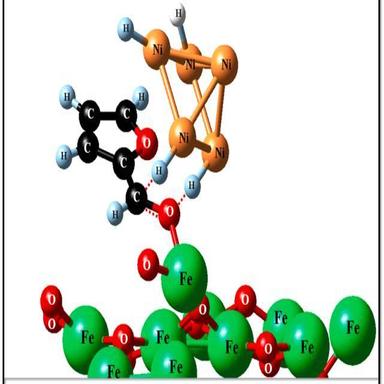
Furfural molecule. Fig. 16. Schematic model for the reduction of furfural molecule.